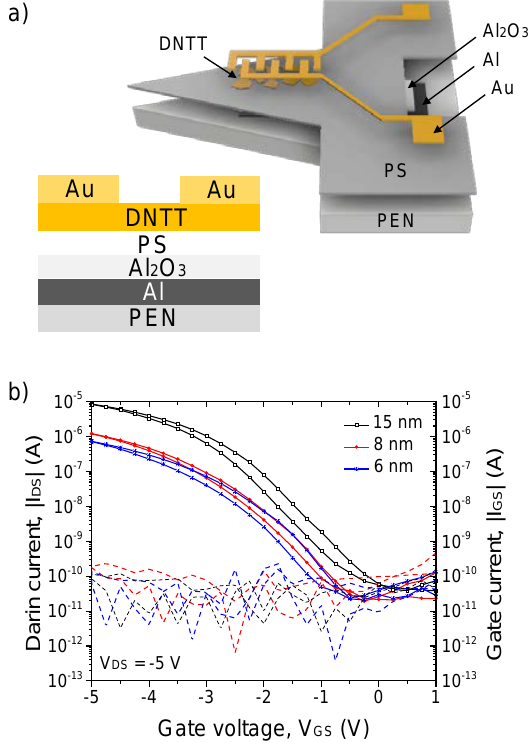
Figure 1. ( a ) Schematic side view of the CantiFET device and its corresponding cross section and ( b ) transfer characteristics of CantiFET with 6, 8 and 15 nm of dinaphtho [2,3-b:2,3-f] thieno [3,2–b] thiophene (DNTT) active layer (solid lines) and their corresponding leakage current (dash lines).